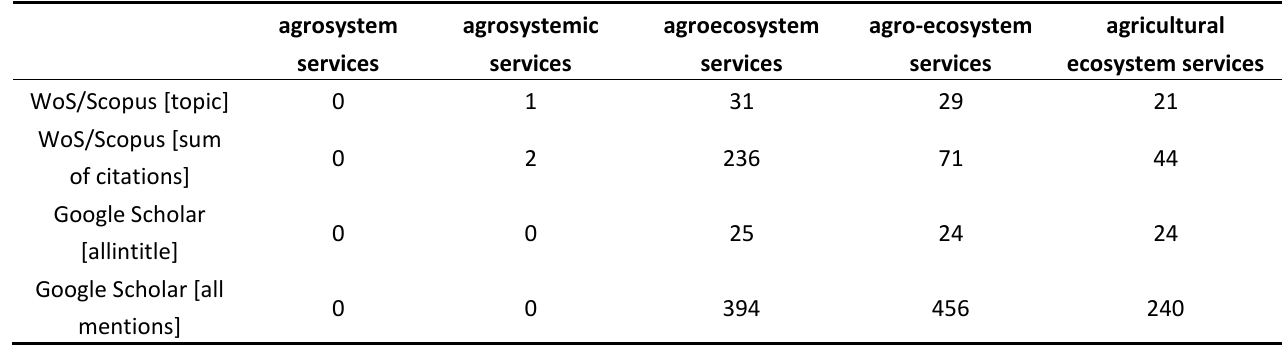
Table 1: Results of the terminologically mining of WoS + Scopus and Google Scholar (2004-2014)